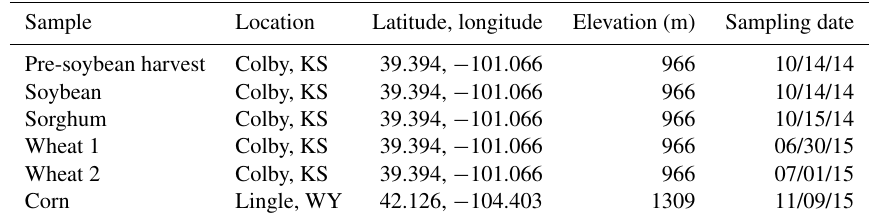
Table 1. Sampling locations, elevations, and dates (given in mm/dd/yy) for all of the harvests are given.